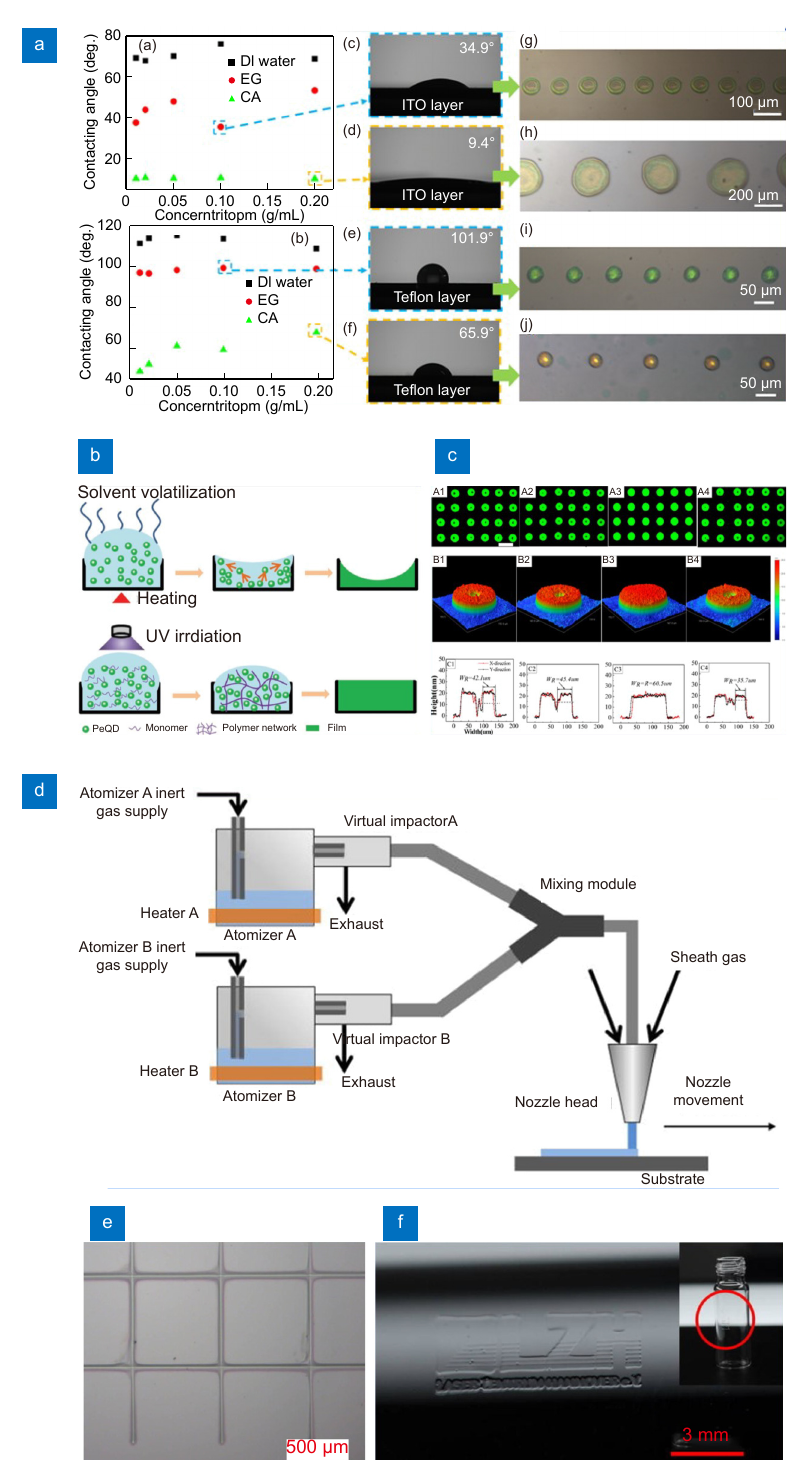
Fig. 10 | ( a ) Relationships between the concentrations of silica particles in colloidal inks and the contact angles of ITO glasses and silicon wafers with Teflon layers. Optical images of the latex droplets and printed photonic crystals microstructures on the ITO glasses and silicon wafers with Teflon layers. ( b ) Schematic illustration of the film forming process using thermal-curing and UV-curing inks, respectively. ( c ) PL microscopic im- ages and 3D morphology images of dot arrays, and film thickness profile of each single dot achieved by printing quantum dots inks with volume ratios of 0, 10, 20, and 30% oDBC. ( d ) Fluid flow schematic of the AJP system with a dual atomizer module 91 . ( e ) Fabricated 2D patterning of a square grid on planar surfaces 91 . ( f ) LZH logo printed on a freeform cylindrical surface 121 . Figure reproduced with permission from: (a) ref. 113 , American Chemical Society; (b) ref. 43 , John Wiley and Sons; (c) ref. 17 , American Chemical Society; (d–f) ref. 91 , AIP